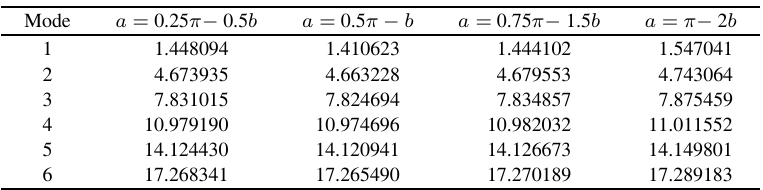
Table 5 Non-dimensional natural frequencies of clamped-free rods with A ( x ) = A 0 sin 3 ( ax + b )